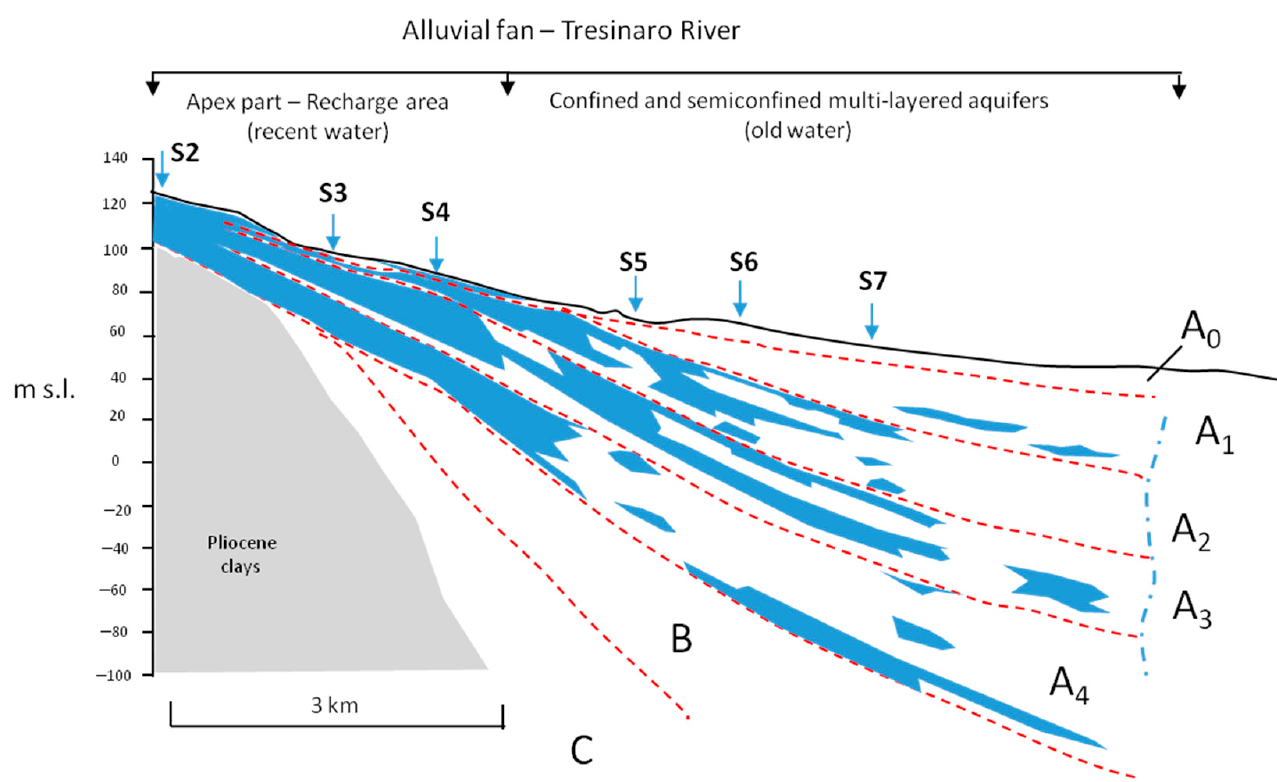
Figure 2. Simplified hydrogeological cross-section of the Tresinaro river alluvial fan along with hydrogeological complexes composing Aquifer Group A (modified after [21,25]; blue parts identify gravels and coarse sand deposits while white ones those areas in which clays and silts are dominant) and river sections in which salt slug injections were carried out (from S2 to S7). Due to a limited number of deep wells, hydrogeological complexes belonging to Aquifer groups B and C are not reported. Readers are referred to Figure 1 for the track line.